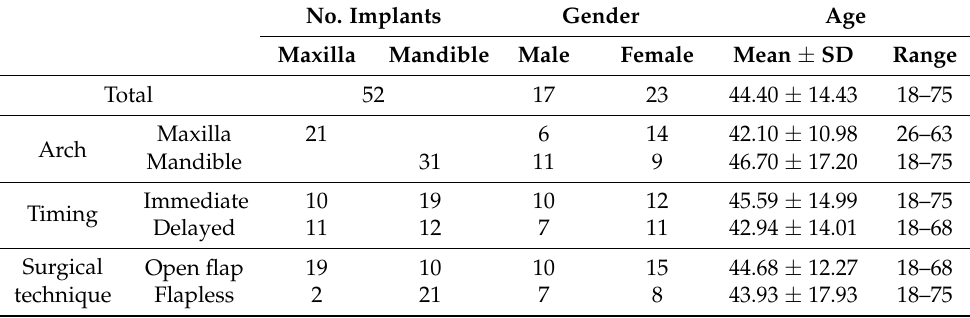
Table 2. Patients and treatment characteristics.